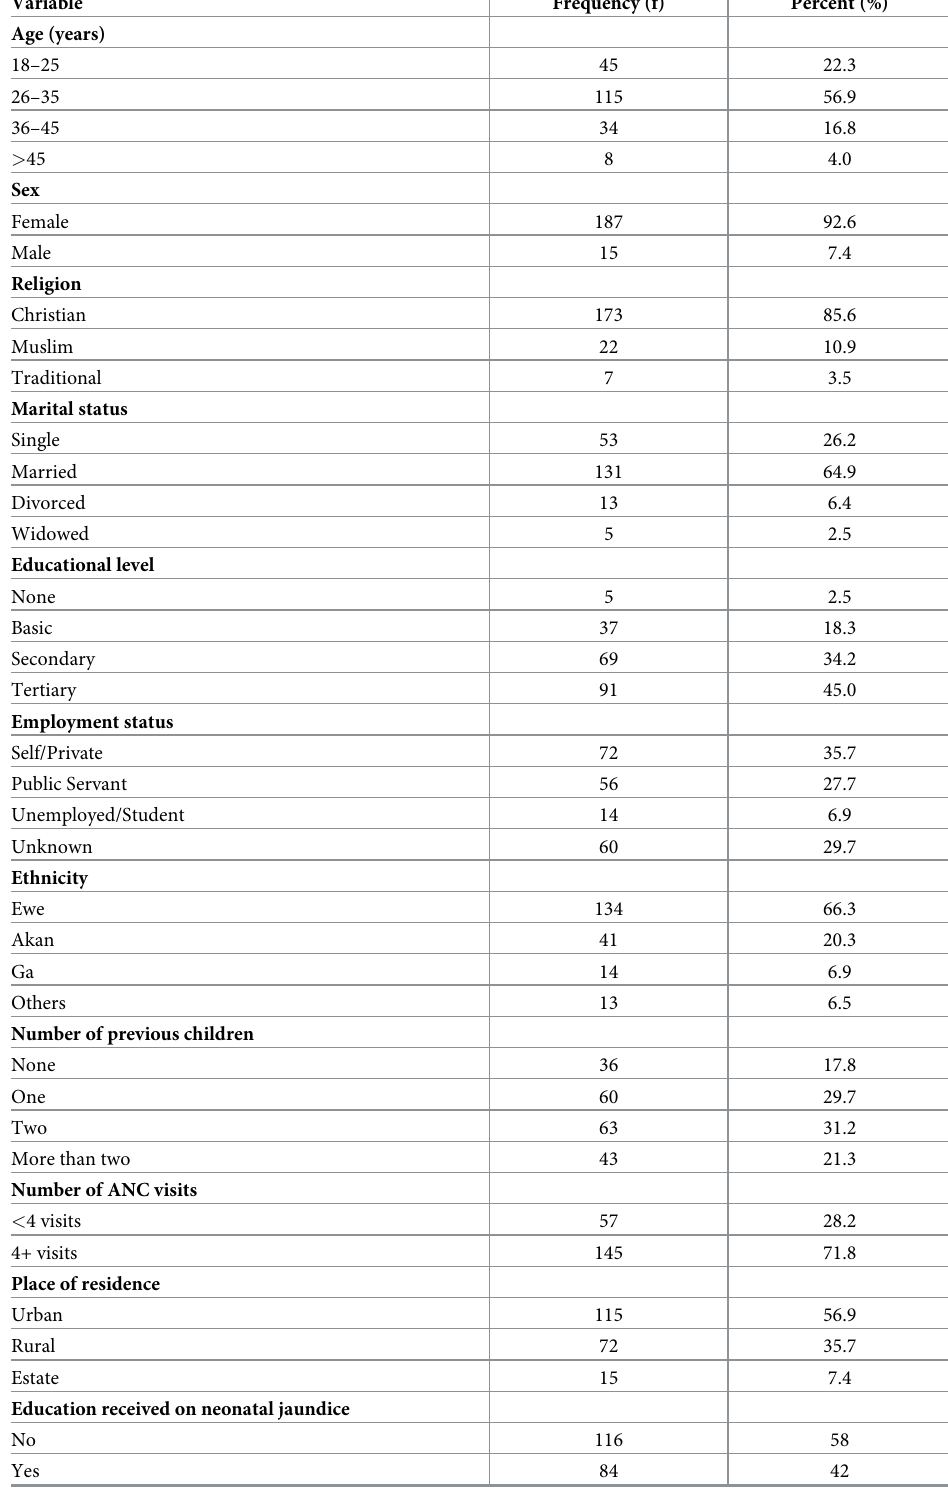
Table 1. Socio-demographic characteristics of